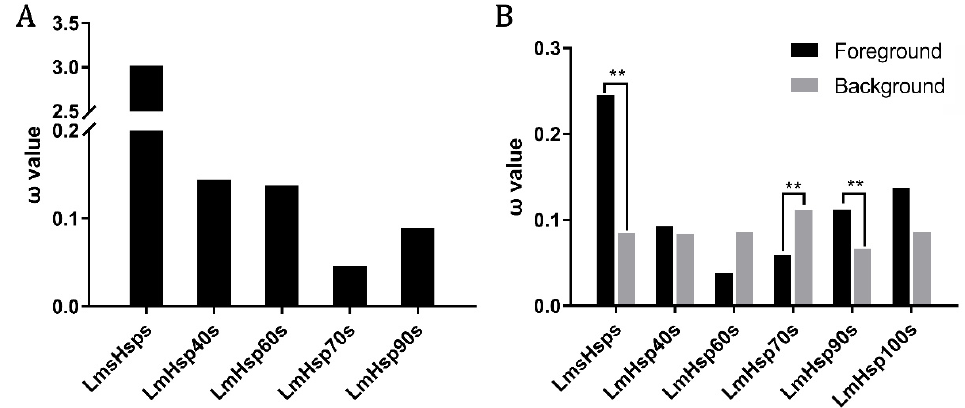
Figure 6. Molecular evolution of LmHsp genes in L. maculatus . ( A ) ω values of each LmHsp family from site model tests; ( B ) Branch-model tests of each LmHsp family from L. maculatus , black and gray columns indicate ω values of each LmHsp family ( ω 1 , foreground branch) and other LmHsp families ( ω 0 , background branch), respectively. ** indicates p < 0.01.